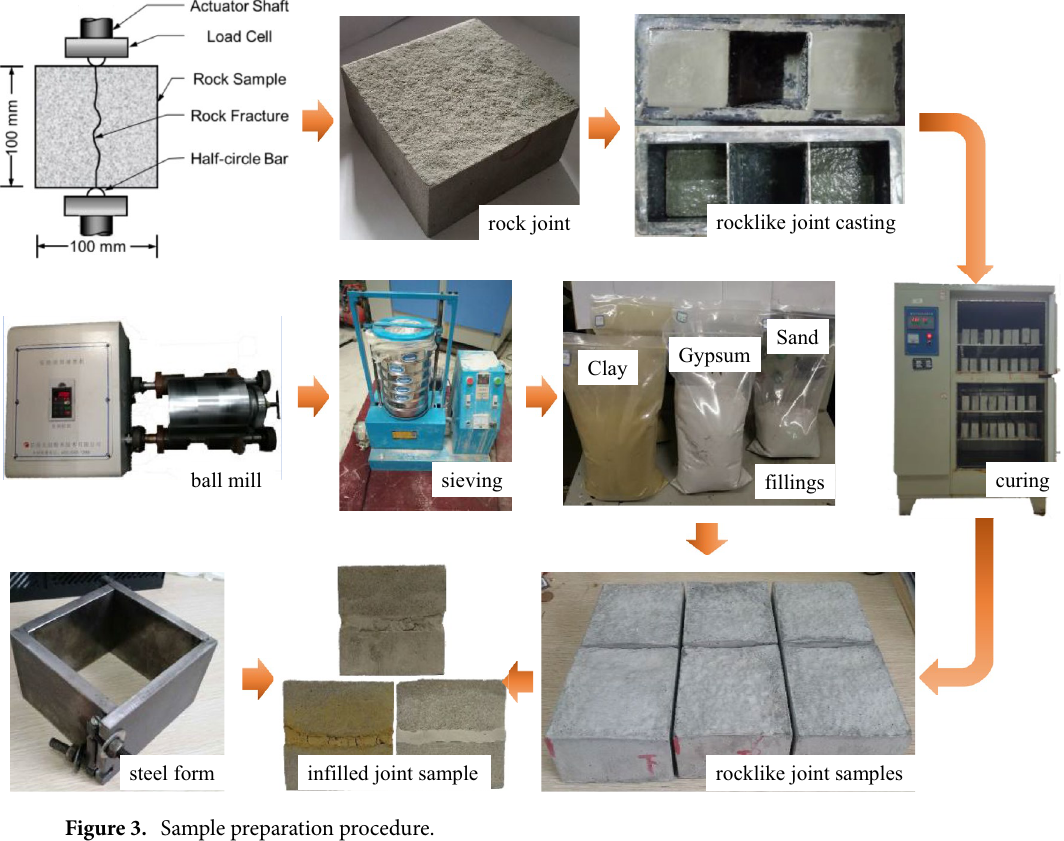
Figure 3. Sample preparation